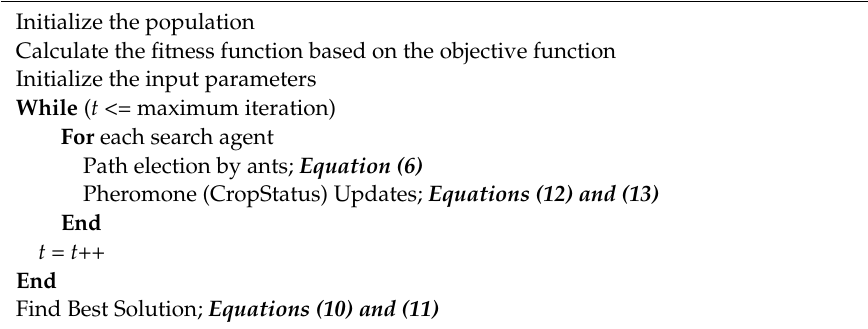
Figure 3. The working mechanism of the RACO. Algorithm 2 Reverse ACO algorithm pseudocode Algorithm 2. Reverse ACO algorithm